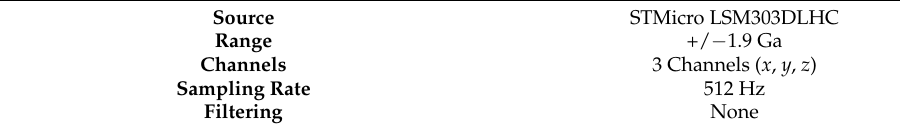
Table A2. Magnetometer specification.